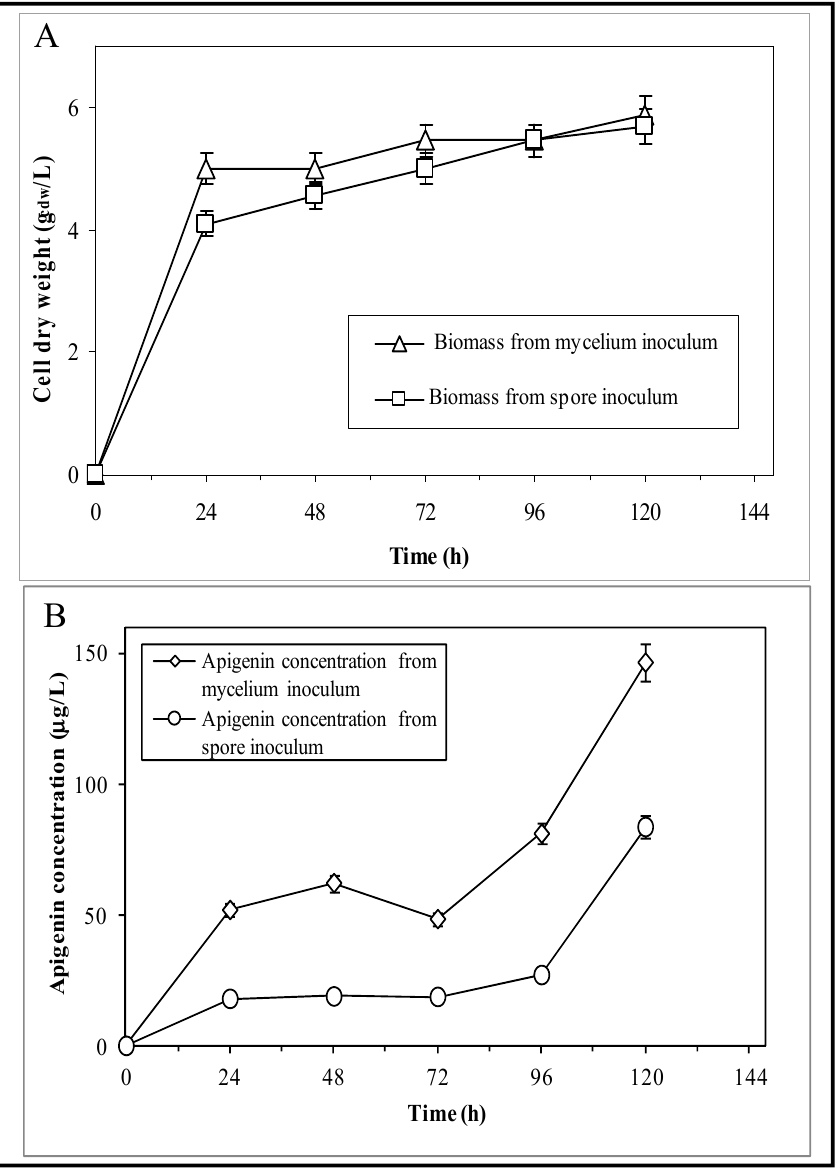
Figure 2. Kinetics of growth of Streptomyces albus- pAPI ( A ) and apigenin concentration ( B ) in shake flasks starting from spore or mycelium inoculum.